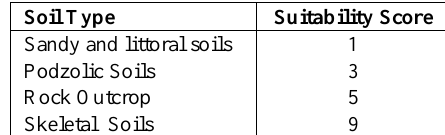
Table 3. Suitability Scores given to each soil type